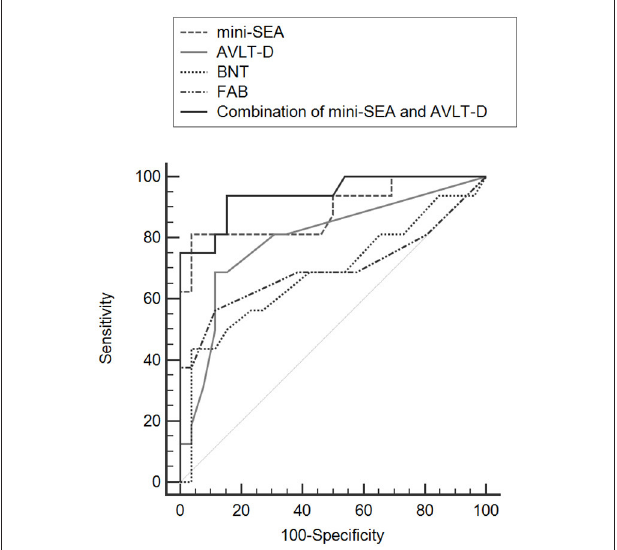
FIGURE 1 | Comparisons of ROC curves for mini-SEA, AVLT-D, BNT, and FAB for discriminating bvFTD from